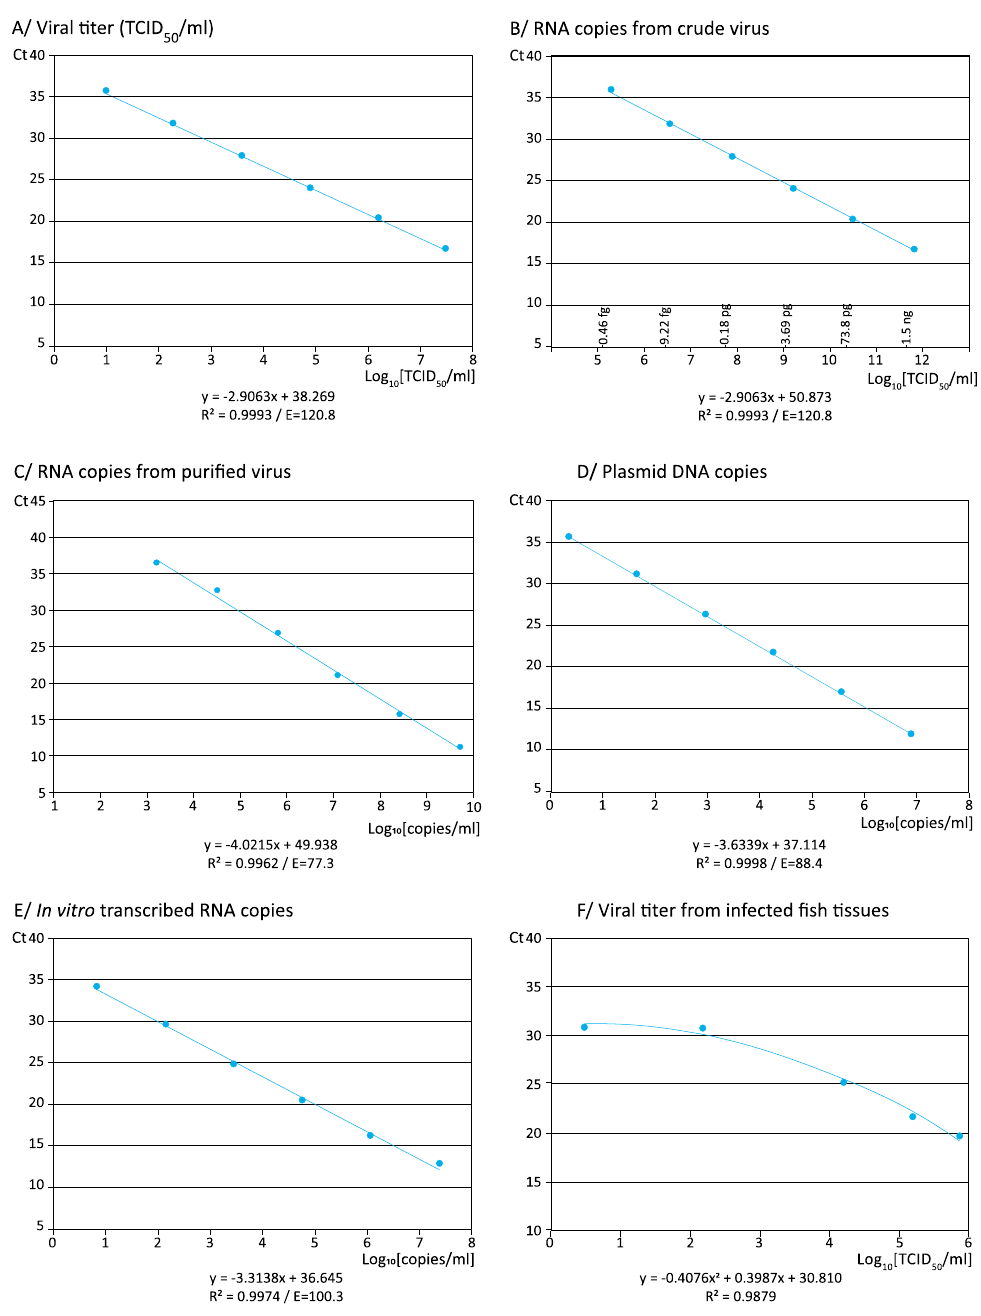
Figure 1. Calibration curves using different standards: averaging data from the four strain types. All the data from replicas and repeats were averaged to obtain a general calibration curve for each standard: viral titer ( A ), RNA copies from crude virus ( B ) or from purified virus ( C ), pDNA copies ( D ), iv RNA ( E ), or for viral quantification from infected tissues ( F ).